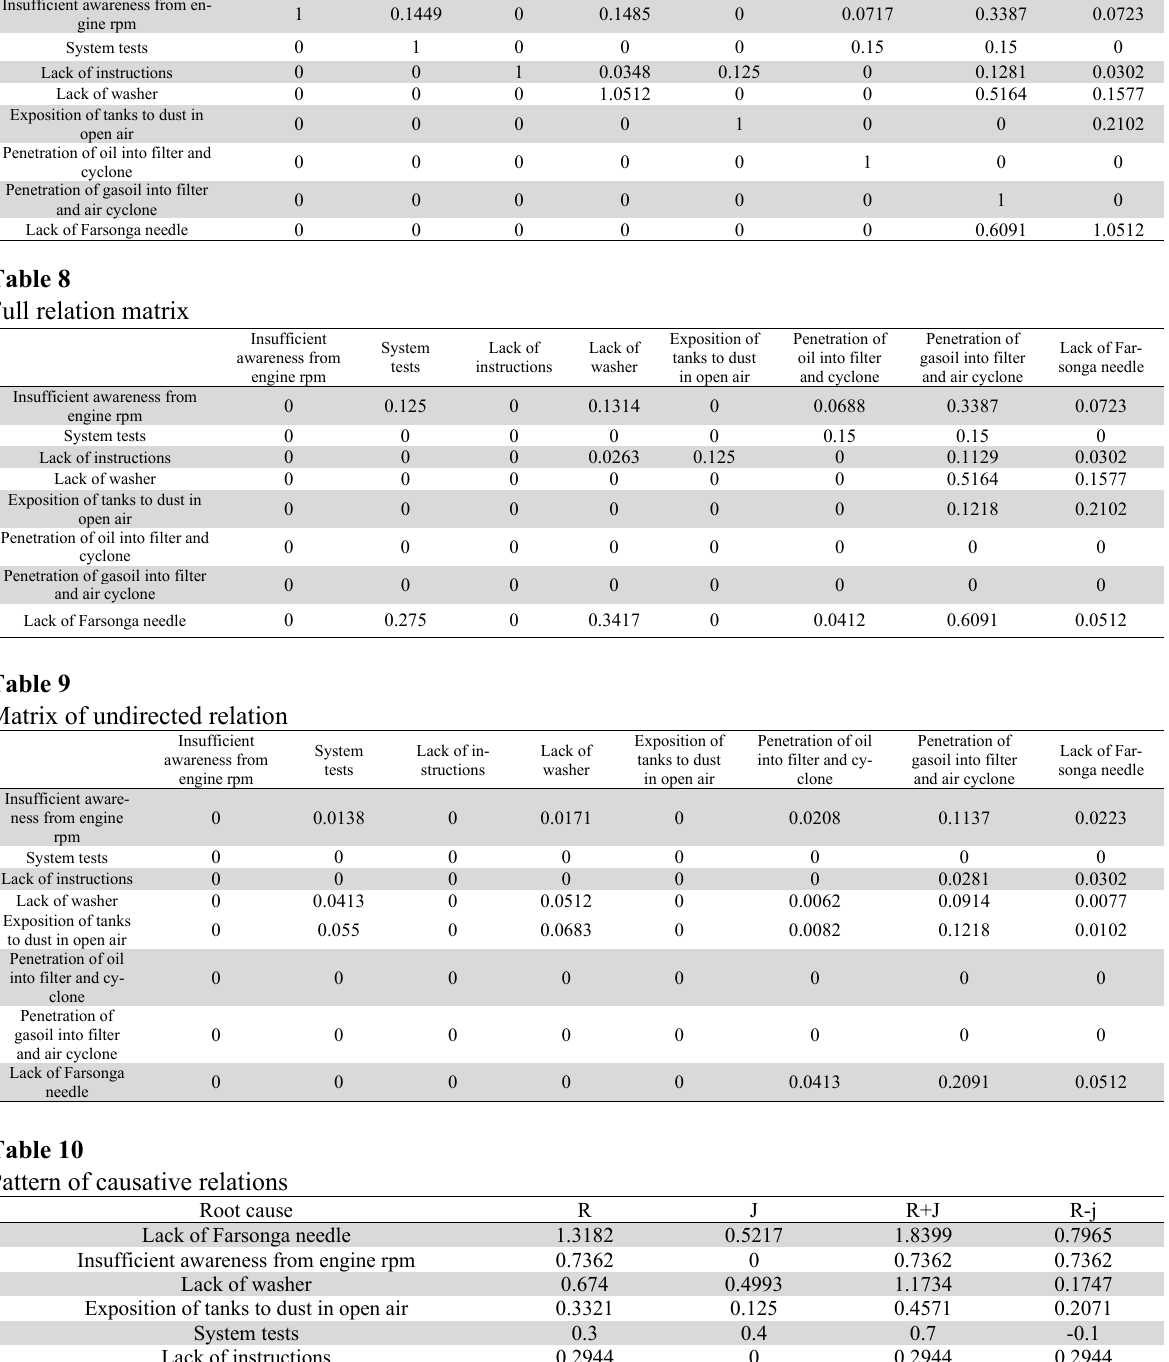
Insufficient awareness from